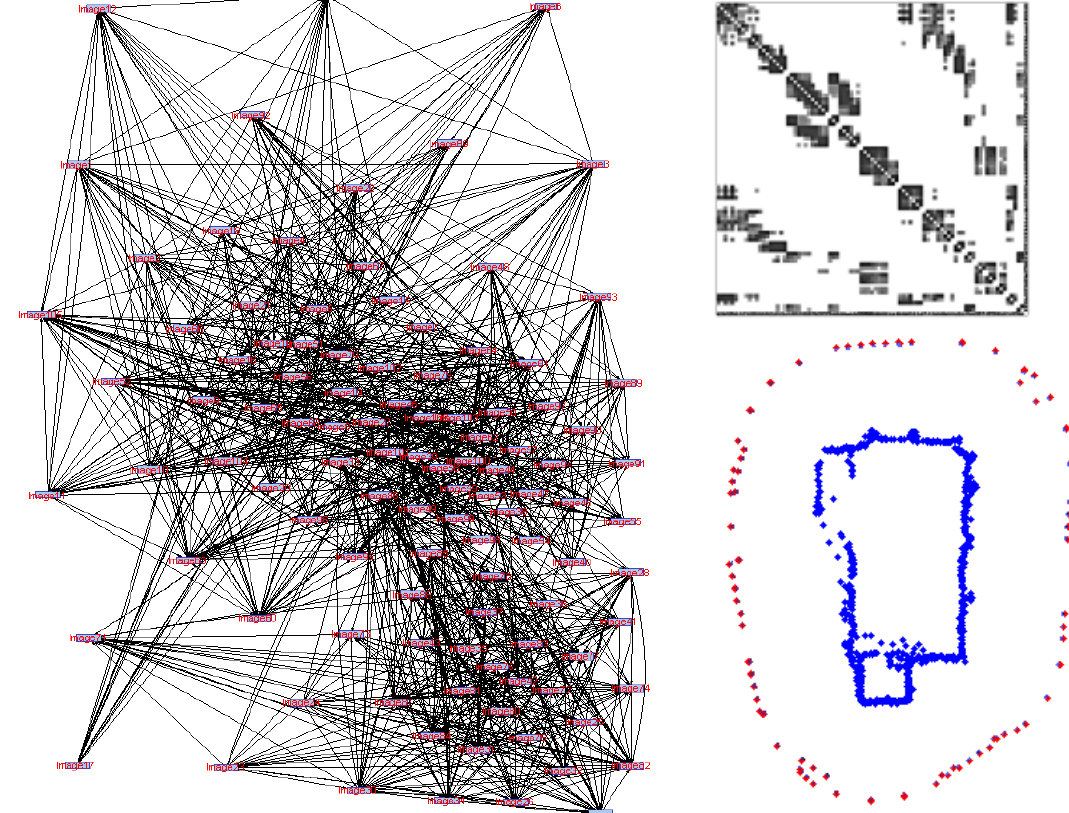
Figure 3. The spanning tree and the matching matrix of a pre-planned network of 106 images